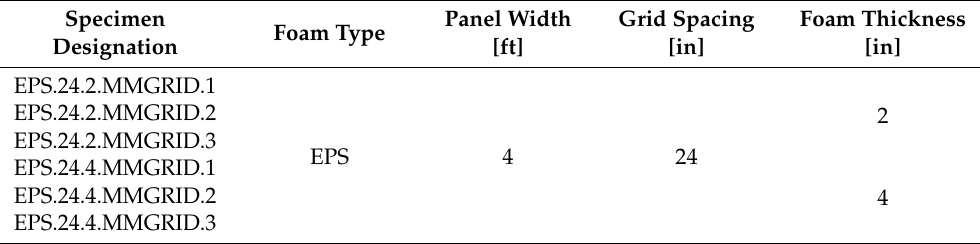
Figure 2. Cross-section of panel specimens with 4 in (102 mm) EPS insulation. Figure 3. Elevation of all panels showing 24 in (610 mm) spacing between CFRP grid strips. 4.2. Material Properties The average concrete compressive strength was measured as 6300 psi (43 MPa) at the time of testing. Concrete strength was measured with 4 × 8 in (102 × 203 mm) concrete cylinders cast alongside the panel specimens.